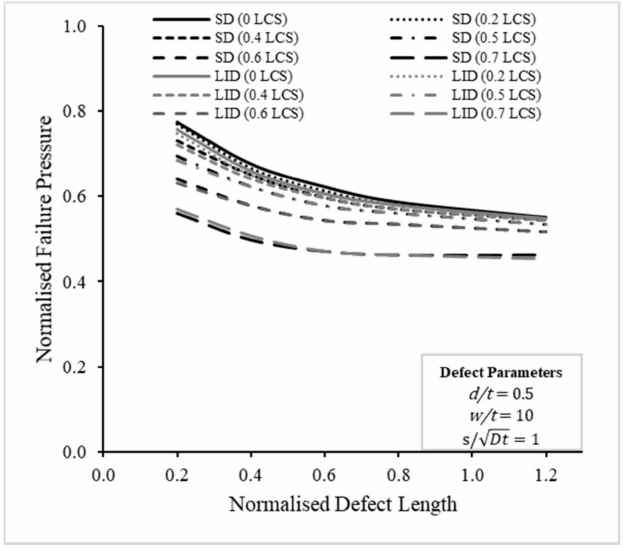
Figure 10. SD and LID comparison of normalised failure pressure predictions versus normalised longitudinal defect spacing across different longitudinal compressive stresses for defect spacing of 1.